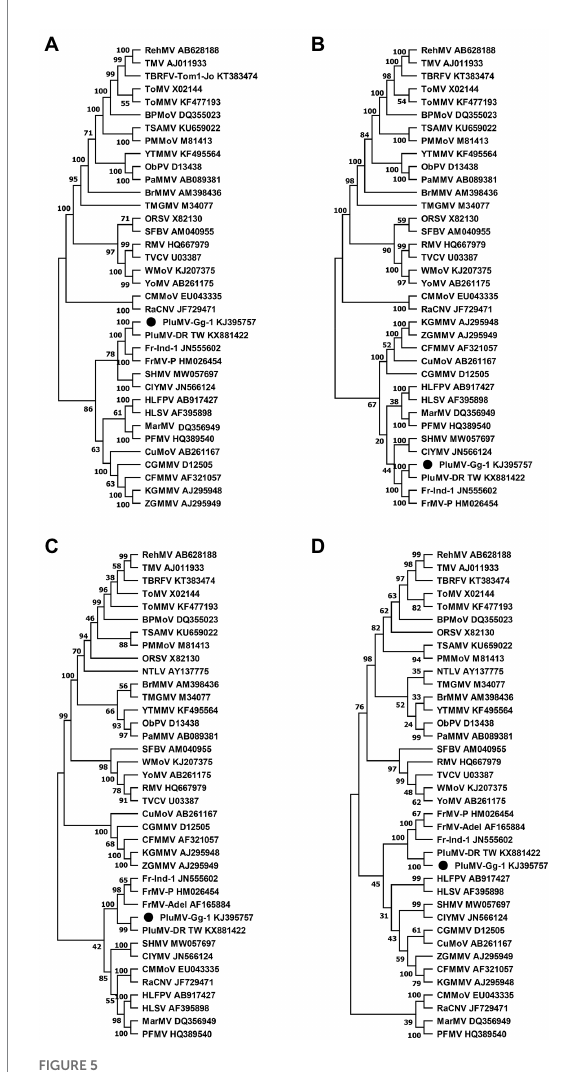
FIGURE 5 Phylogenetic tree of plumeria mosaic virus isolate, PluMV- Plu-Ind-1 and members of the genus Tobamovirus based on the 188 kDa large replicase protein (A) , the 130 kDa small replicase protein (B) , the 30 kDa movement protein (C) , and the 18 kDa coat protein (D) . The tree was constructed based on maximum likelihood method using MEGA version 11 with 1,000 bootstraps value. Full name of the viruses is indicated in Table